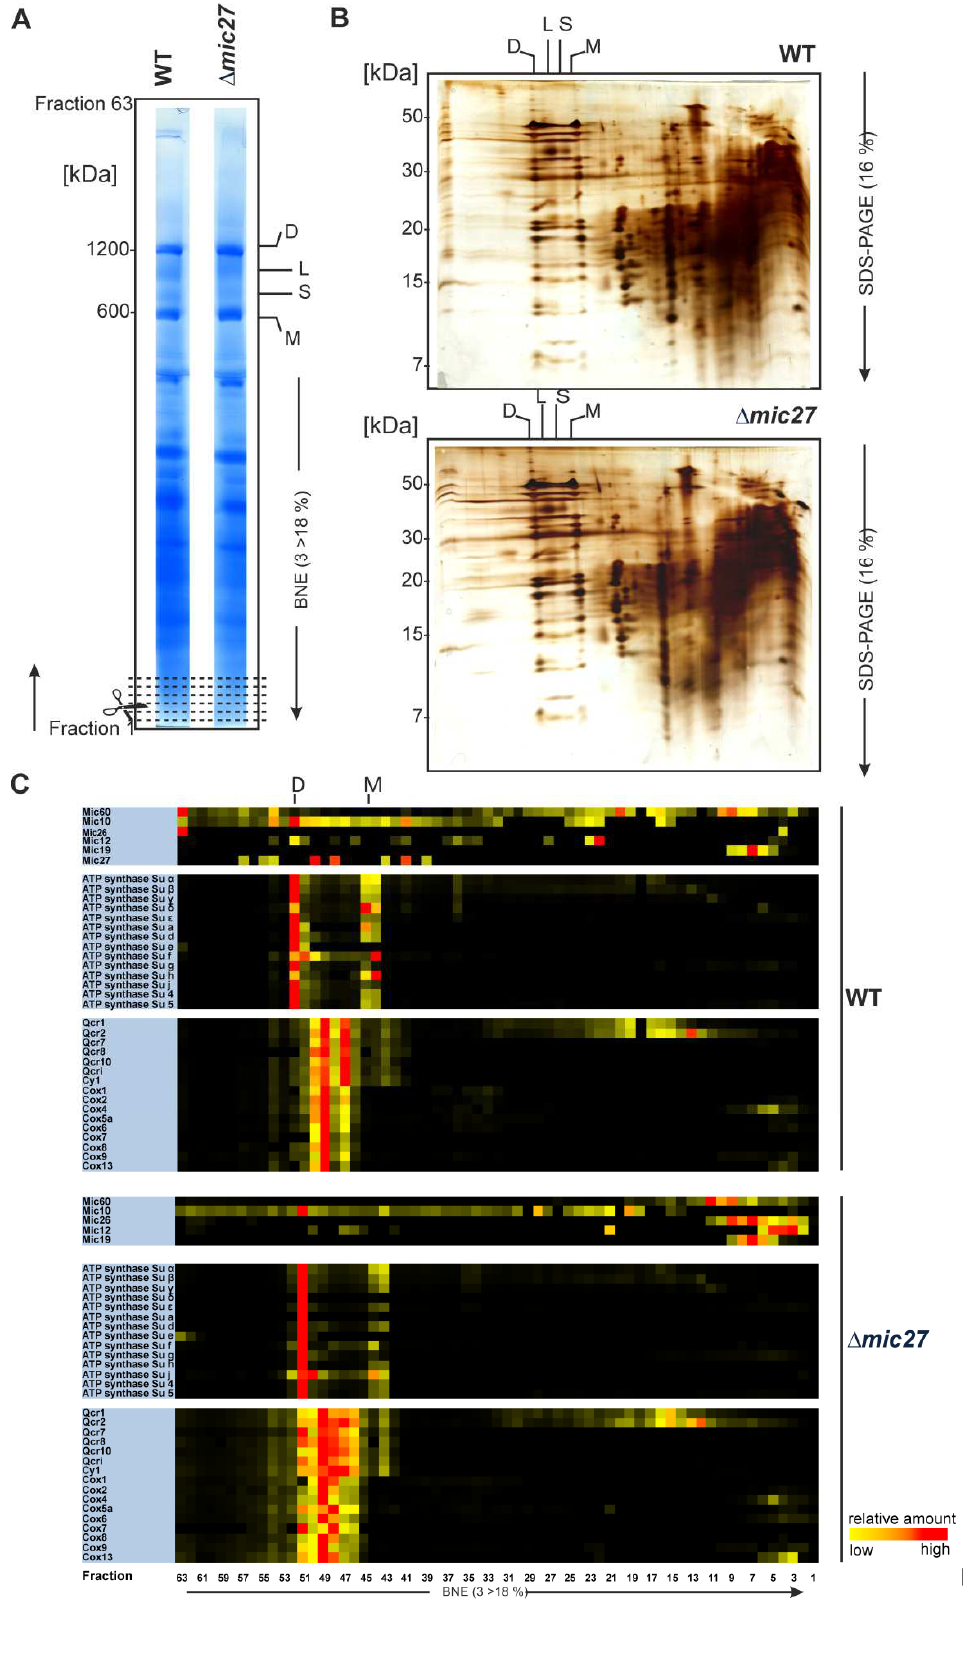
FIGURE 2: Complexome profiling of isolated mi- tochondria from wild type and Δ mic27 cells. Mitochondria were sol- ubilized with digitonin (ratio: digitonin to pro- tein 2g/g) and separated with a BN-PAGE (A) or a 2D BN-PAGE/SDS-PAGE was performed (B). 1D BN-PAGE lanes (indicat- ed in panel A) were fixed and stained with Coo- massie, sectioned trans- versely in 63 fractions, and examined by quanti- tative mass spectrome- try. Selected quantified proteins were repre- sented in heat maps (C). The color scale ranges from black (not identi- fied), to yellow (20% of the maximum), to red (maximum abundance). Monomers (M), dimers (D), and oligomers of the F F -ATP synthase (O) 1 O are